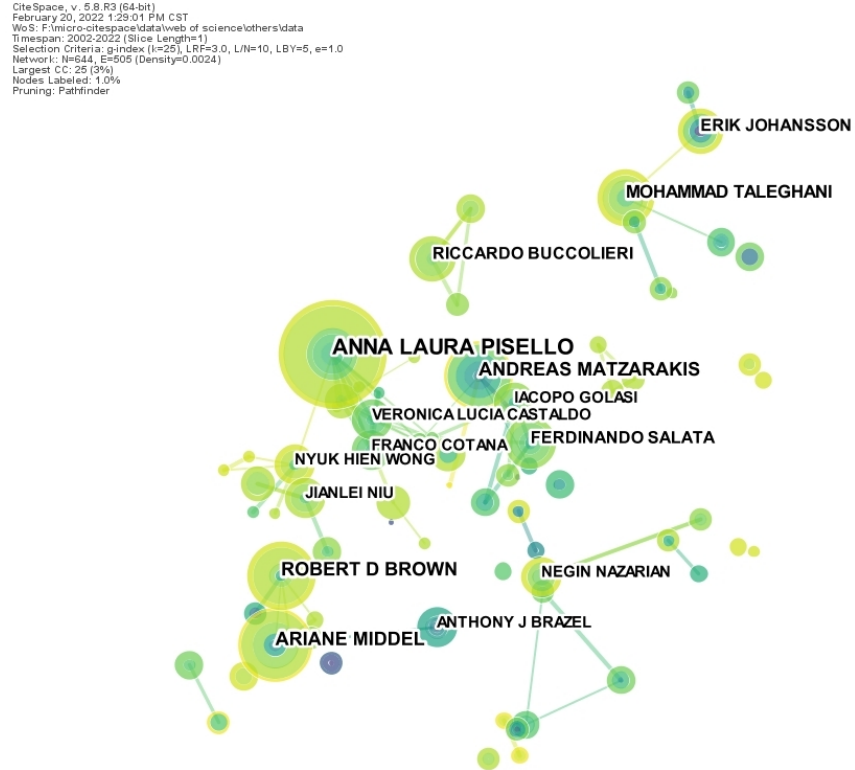
Figure 3. Authorship mapping of foreign scholars in landscape microclimate.